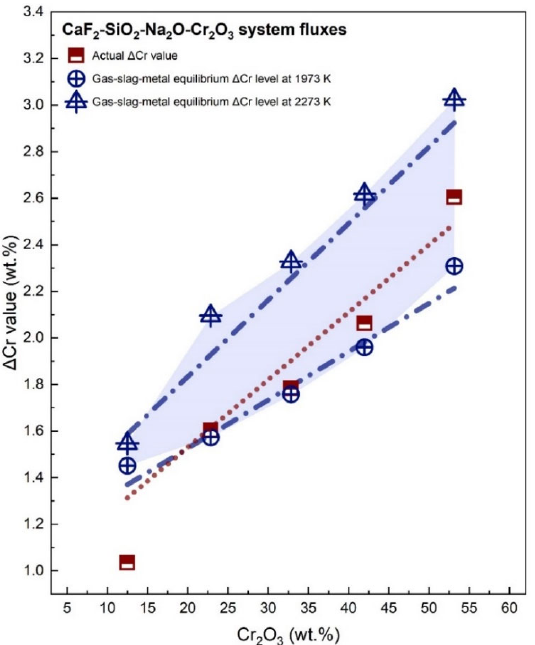
Figure 4. Actual and predicted Δ Cr levels as a function of the Cr 2 O 3 addition level in the flux.